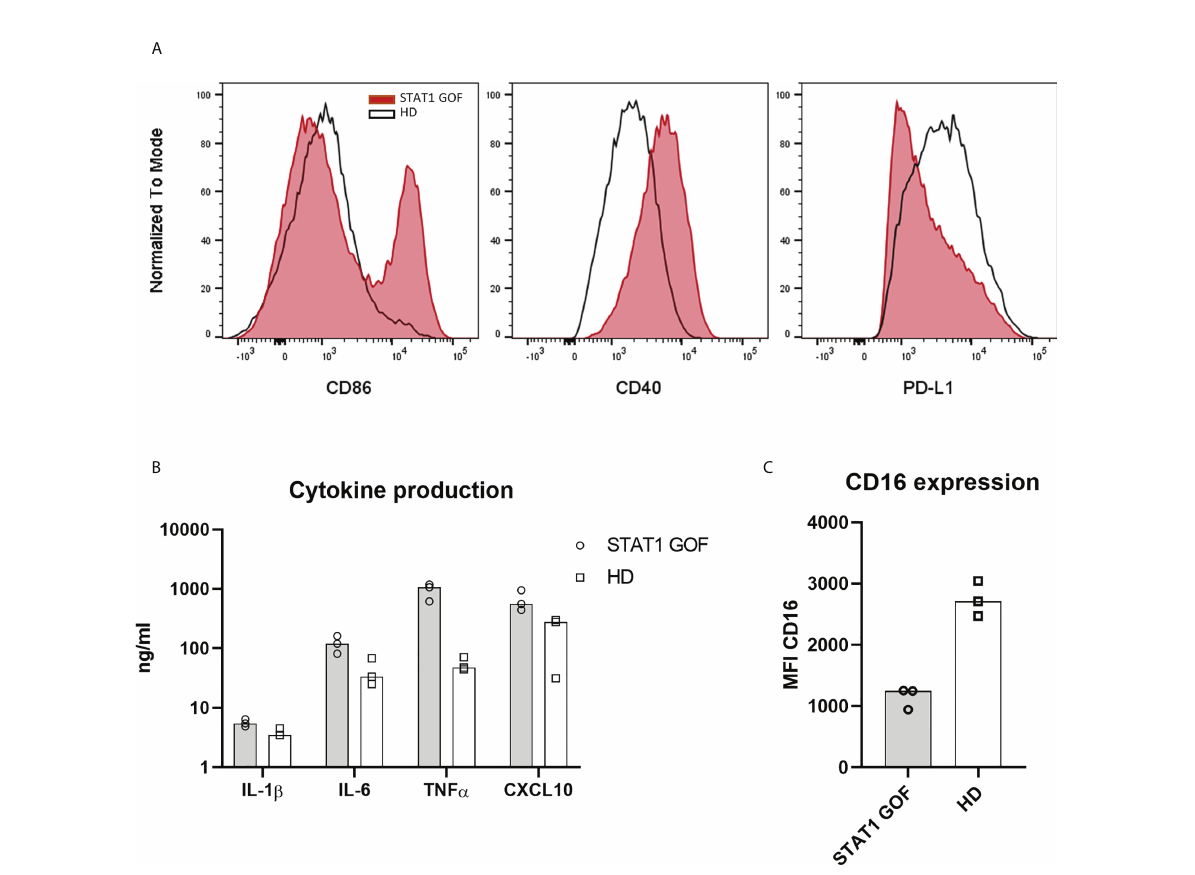
FIGURE 4 Monocyte-derived derived dendritic cells model (A) Expression of CD86, CD40 and PD-L1 on moDCs ’ surface of STAT1 GOF (n = 3) and HDs (n = 3) detected by fl ow cytometry (B) Cytokine production of STAT1 GOF (n = 3) and HDs ’ (n = 3) moDCs detected by LUMINEX (C) CD16 expression on moDCs ’ surface of STAT1 GOF (n = 3) and HDs (n = 3) detected by fl ow